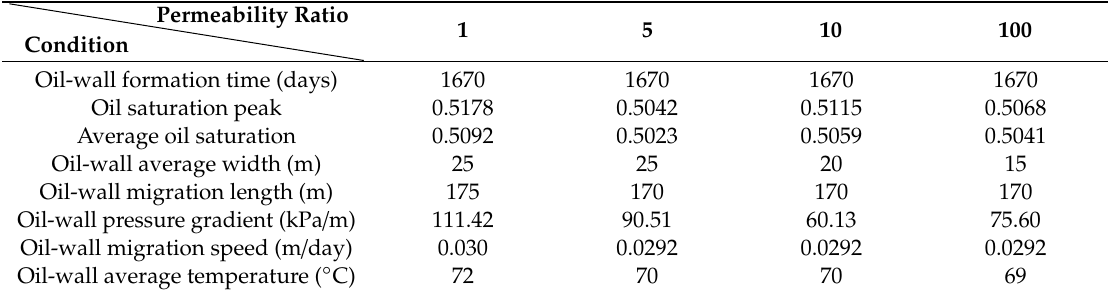
Table 16. Characteristic parameters of oil-wall with di ff erent permeability ratio.